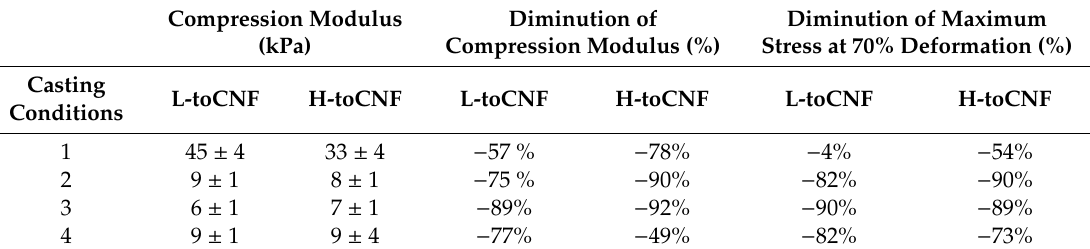
Figure 10. Representative compression curves for dry and swollen H-toCNF cryogels. Table 6. Diminution of mechanical properties between the dry and swollen states.